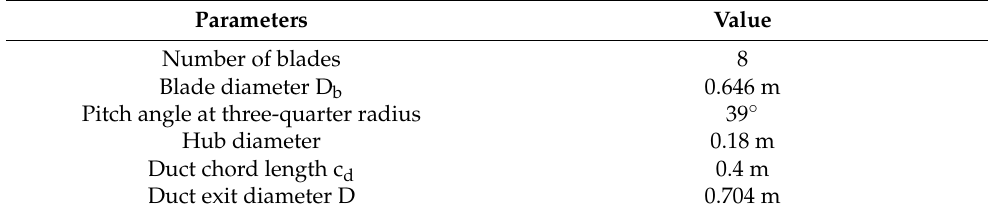
Figure 2. Blade chord and twist distributions. Table 1. Main parameters of the ducted fan.